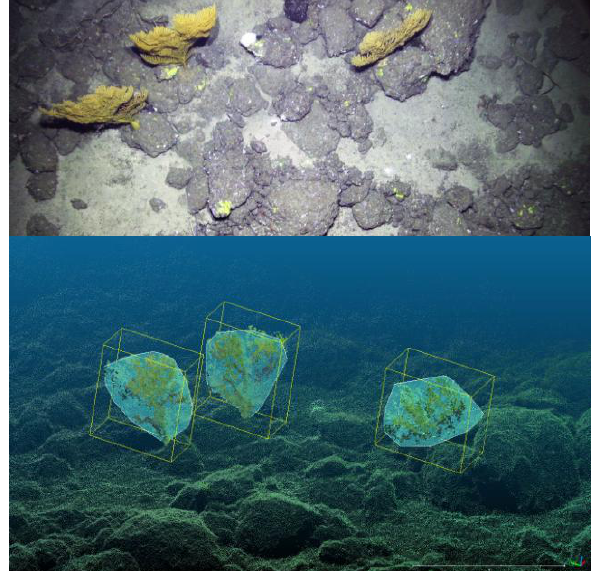
Figure 4. (Up) video frame with three colonies of Placogorgia sp . (Down) Planes fitted to assess gorgonian fan surface using CloudCompare semi-automatic